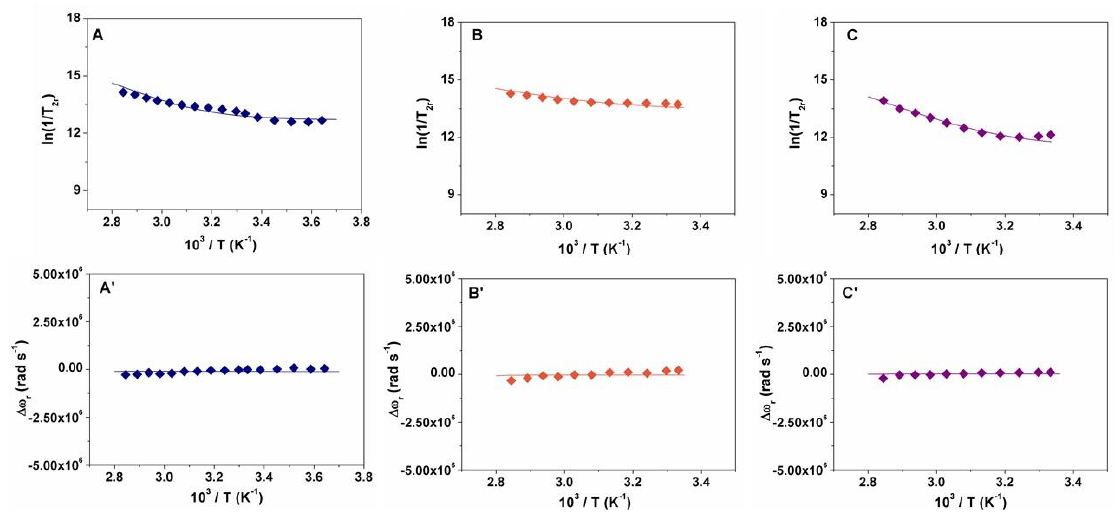
Figure 3. Reduced 17 O NMR transverse relaxation rate and 17 O NMR chemical shift measured at 67.8 MHz (11.74 T) for GdL1 (( A , A′ ) 10.1 mM), GdL2 (( B , B′ ) 6.7 mM) and GdL3 (( C , C′ ) 24.6 mM). The solid lines represent the fit of the data with the parameters reported in Table 1.